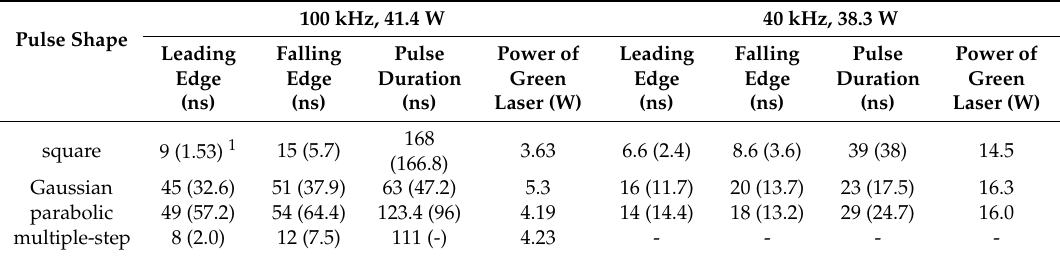
Table 2. Temporal parameters of 1064 nm and an output power of 532